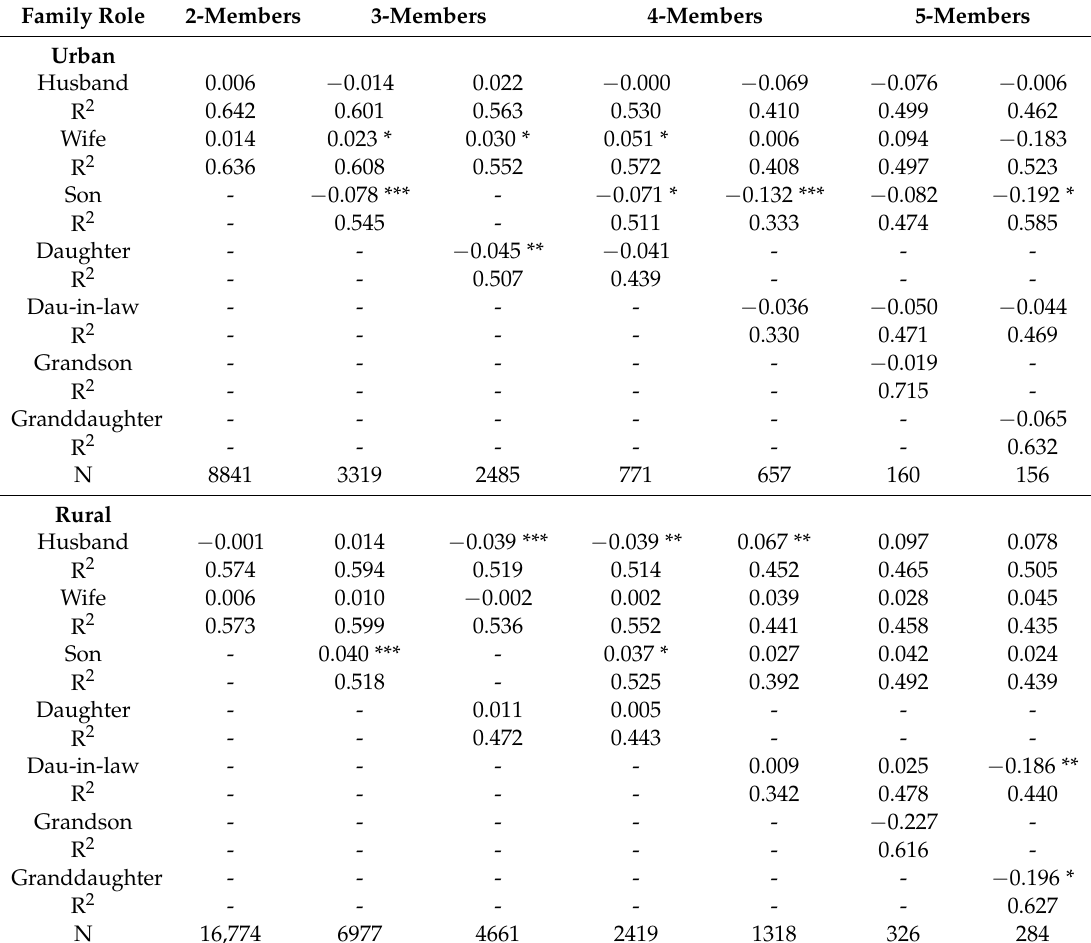
Table A4. Intra-household intake ratio regression results (dependent variable: ln individual calorie ratio).